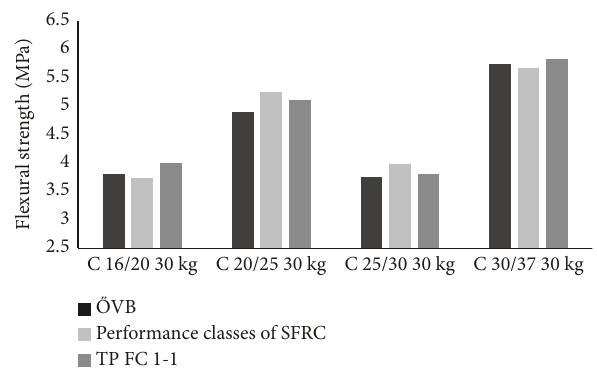
Figure 5: Bending strength of SFRC—amount of fibers: 30kg/m 3